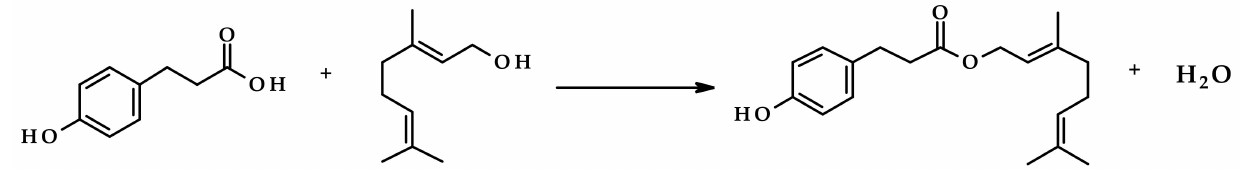
Figure 1. Scheme of geranyl 4-hydroxyphenylpropanoate